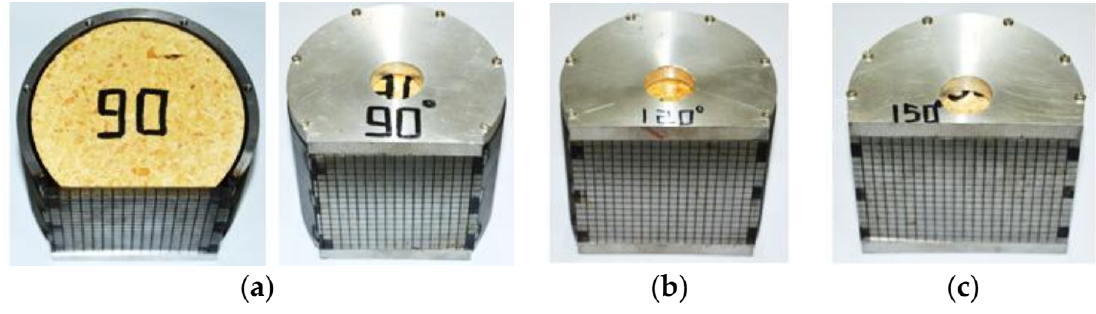
Figure 2. Assembly drawing of three different D-shaped devices. ( a ) D-90 ◦ ; ( b ) D-120 ◦ ; ( c ) D-150 ◦ .